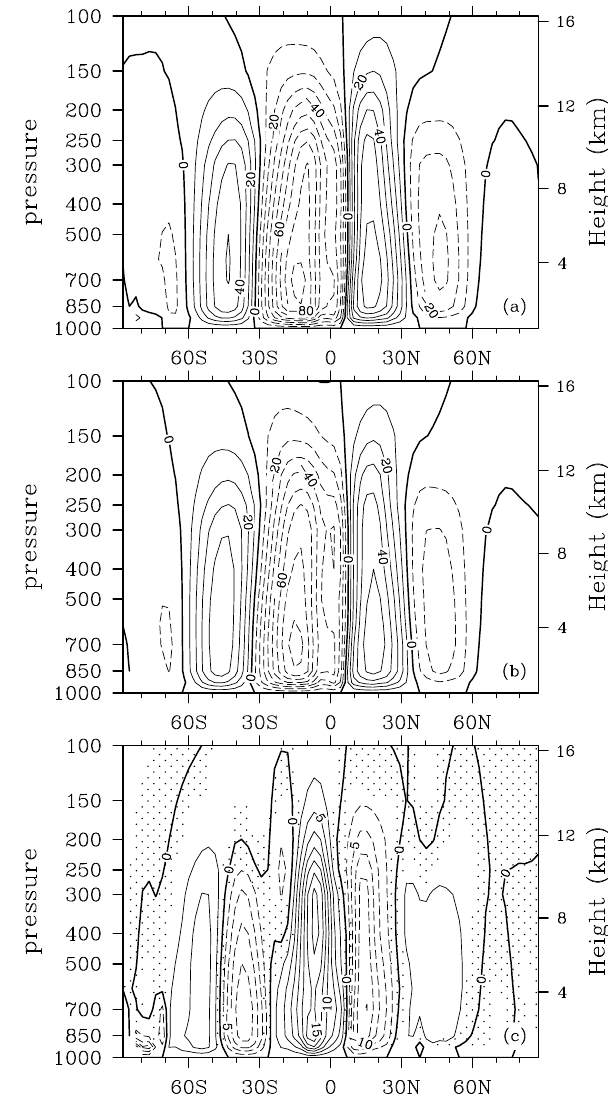
Fig. 5. Mass stream function ( × 10 9 kgs − 1 ) of the annually aver- aged zonal mean meridional circulation in the pre-industrial (a) , the mid-Pliocene (b) and the differences between the mid-Pliocene and pre-industrial (c) . Areas with a confidence level less than 95% are